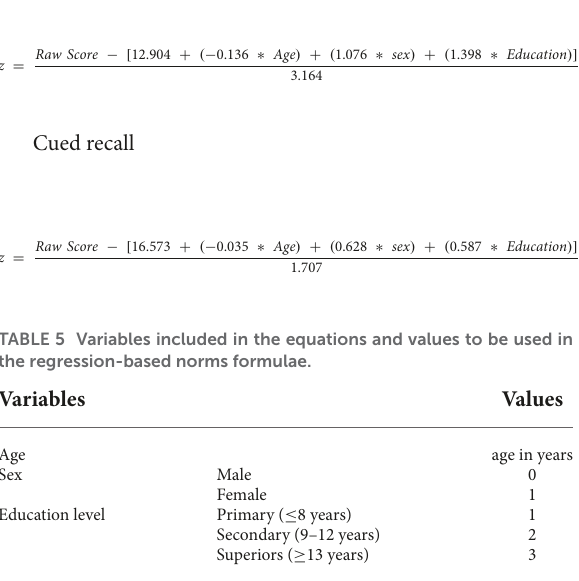
the regression model (for biological sex we created a dummy variable; see Table 5 for values used), multiplied for not standardized “B” coefficients, model constant (k), and the Root Mean Square Error (RMSE):